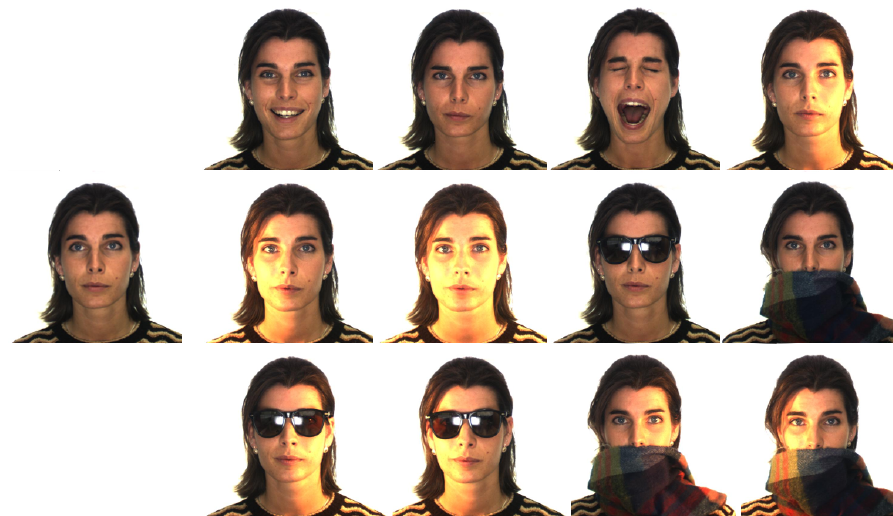
Figure 5. Examples of AR images (session 1). On the left, the neutral image; the others are the test images representing the different